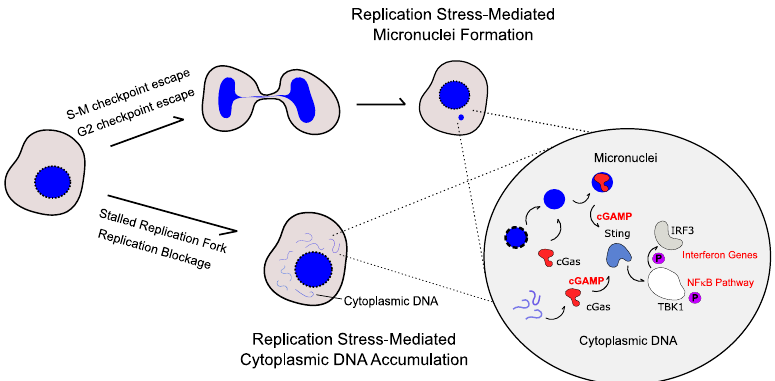
Figure 1. cGAS-STING pathway activation by replicative stress. Two di ff erent pathways can trigger cGAS-STING activation by replicative stress: (1) the formation of micronuclei and (2) the accumulation of replication fork-derived DNA in the cytoplasm. These events will trigger the activation of cGAS, which produces cGAMP, activating the STimulator of INterferon Genes (STING) protein. Once activated, STING recruits TBK1 that is then able to phosphorylate its di ff erent targets that include Interferon Regulatory Factor 3 (IRF3) and di ff erent members of the NF- κ B signalling pathway. This culminates in an upregulation of pro-inflammatory factors.